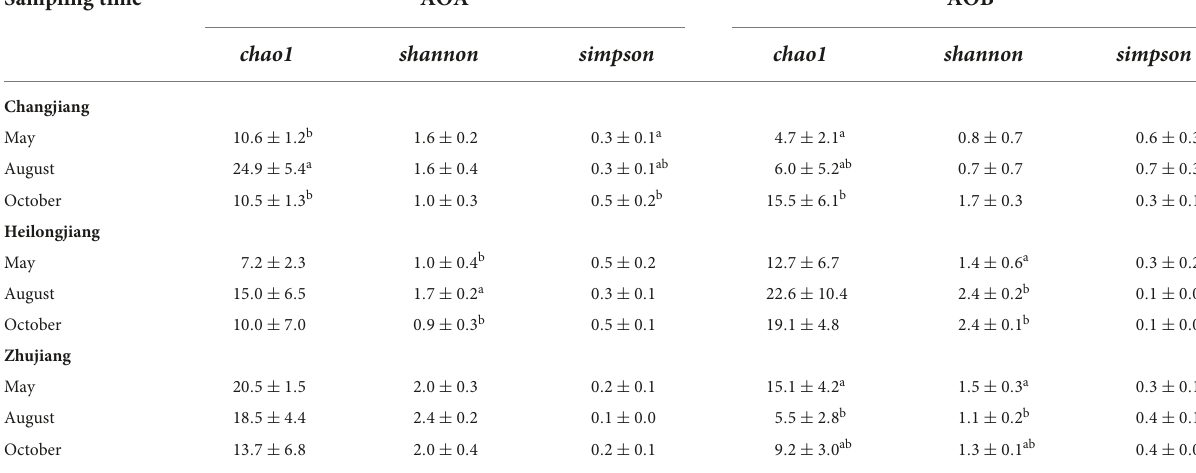
TABLE 2 Microbial diversity of different pond sediment samples at different sampling times*. Sampling time